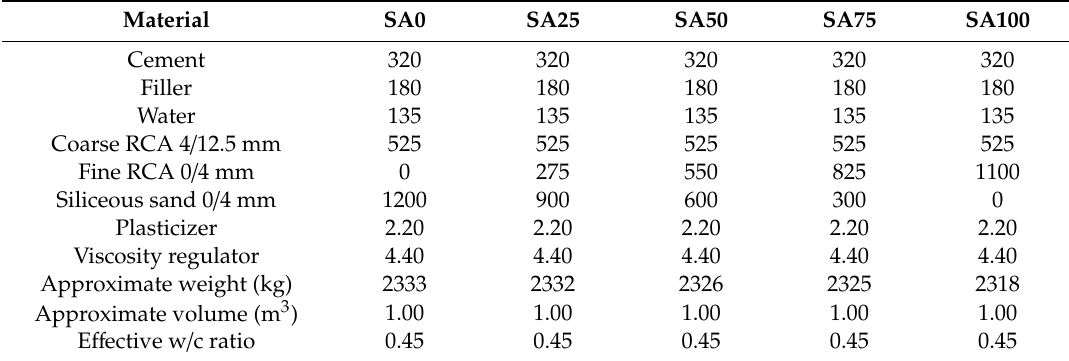
Table 4. Mix design (kg / m 3 ).